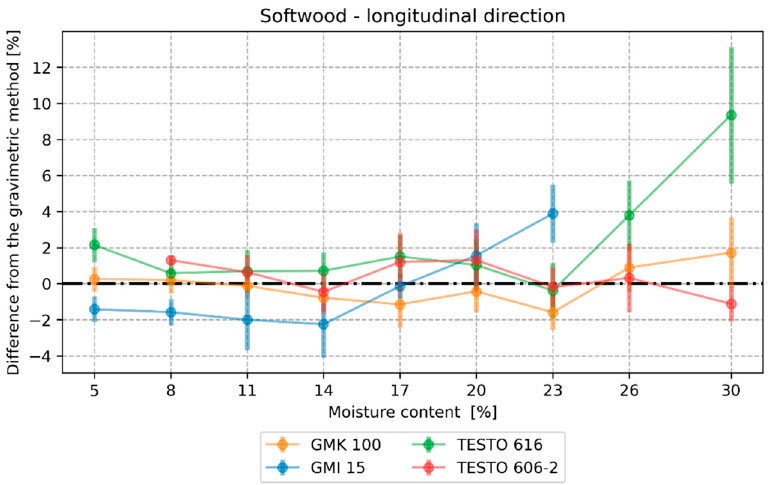
Figure 3. Comparison of average values of differences from the gravimetric method in the longitu- dinal direction of spruce wood using selected moisture meters GMI 15, GMK 100, Testo 616 and Testo 606-2 in different moisture conditions.